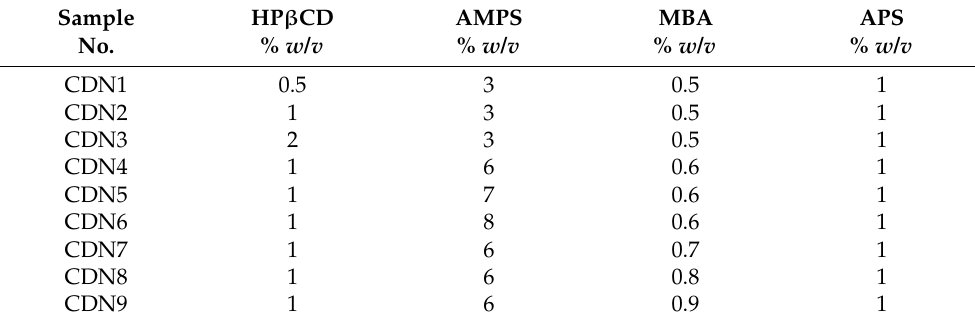
Table 1. Composition of CD-based polymeric